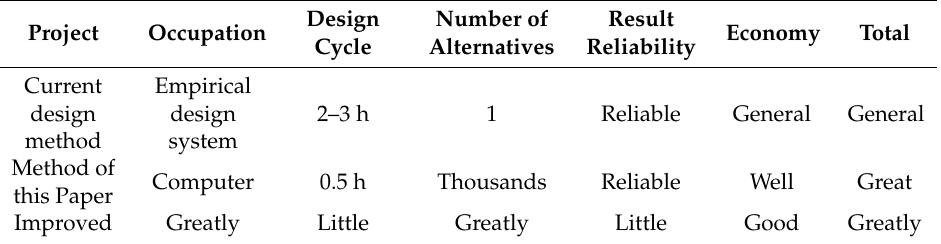
Table 10. Performance